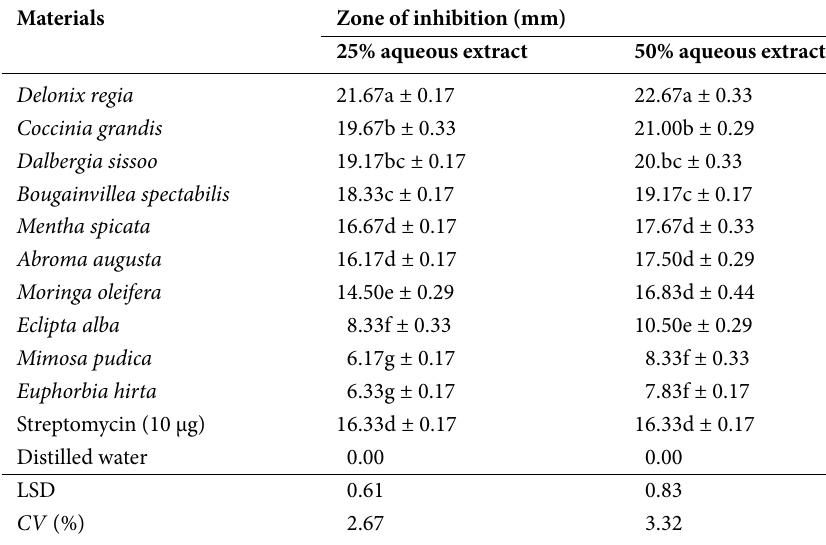
D ata given are mean of three replicates ± standard error, p < 0.05.